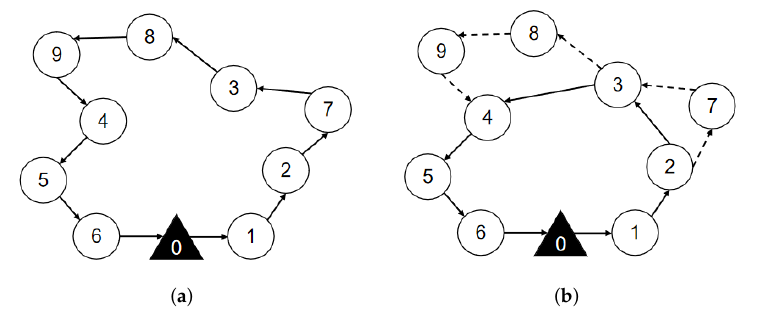
Figure 3. The initial solution schematic diagram by combining the nearest neighbor and cost- savings strategies. ( a ) Truck only for surveillance targets. ( b ) Cooperation of a truck and drones for surveillance